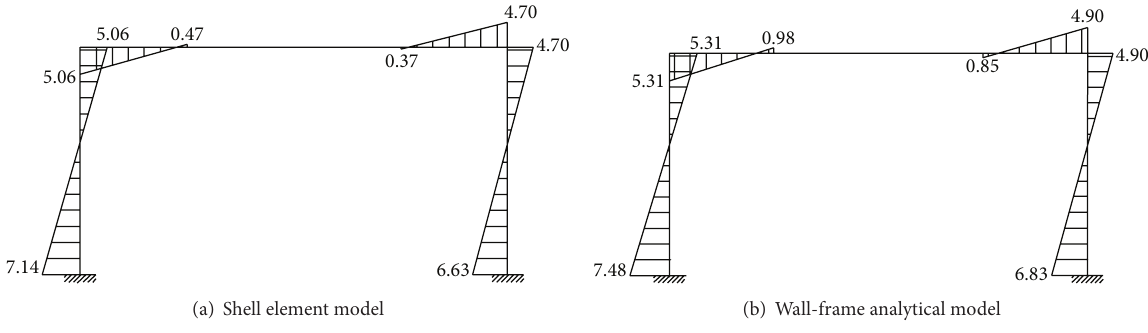
Figure 15: Load-displacement curves from test, shell element model, and simplified model.